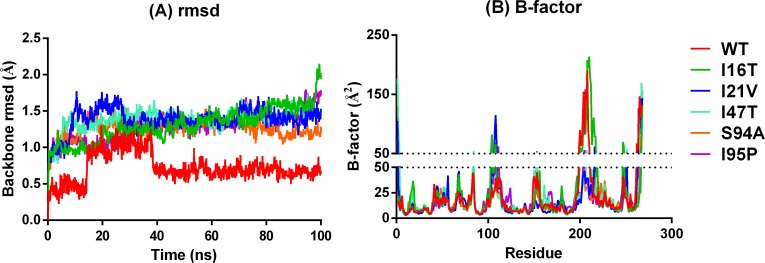
(A) InhA backbone rmsd and (B) B-factor of WT and MTs.